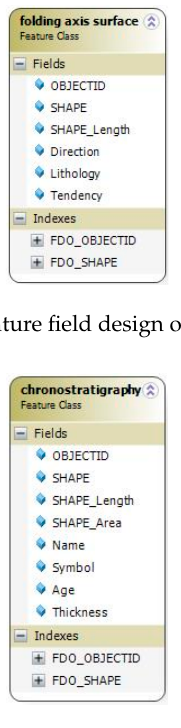
Figure 10. Feature field design of a chronostratigraphic element.